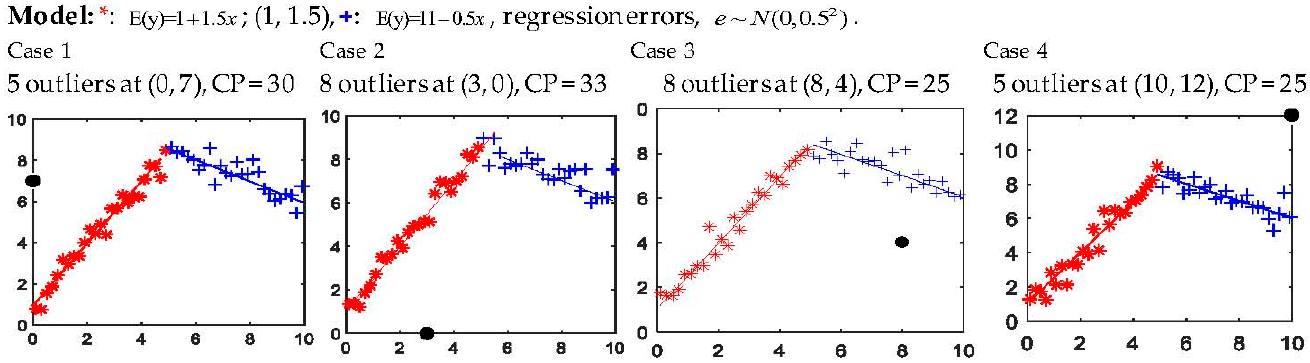
Figure 4. Four cases of extreme outliers considered to show the robustness of the proposed methods. Table 3. Comparing the robustness of 7 methods to extreme outliers using model b under four situations. 5 ( 9.1% ) Outliers, Case